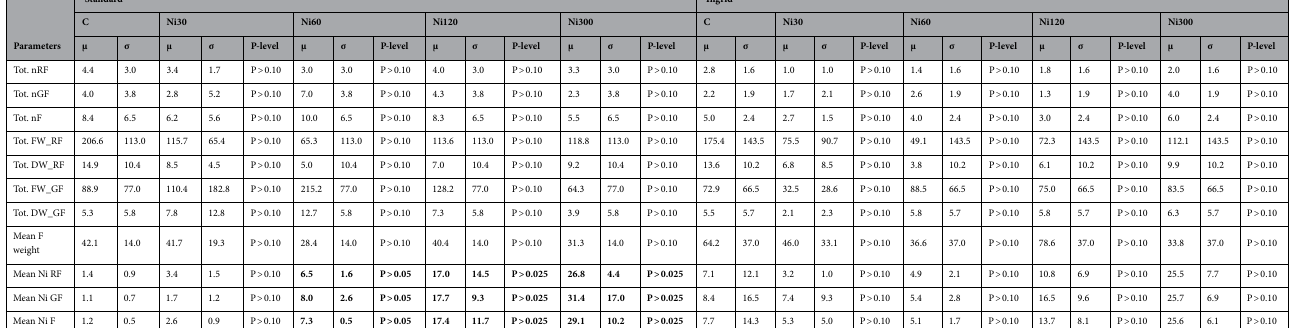
Table 3. Kolmogorov–Smirnov two-sample test for comparison of controls (C) with the other Ni treatments (Ni 30, Ni 60; Ni 120; Ni 300 mg kg −1 , respectively) with compared to mean μ and standard deviation σ considering tomato biomass parameters and Ni accumulation in fruit and the two cultivars used (‘Standard’ and ‘Ingrid’). P-levels are reported. Tomato parameters legend. Tot. nRF total number of red fruits, Tot. nGF total number of green fruits, Tot. nF total number of fruits (red + green), Tot. FW_RF total fresh weight of red fruits, Tot. DW_RF total dry weight of red fruits, Tot. FW_GF total fresh weight of green fruits,